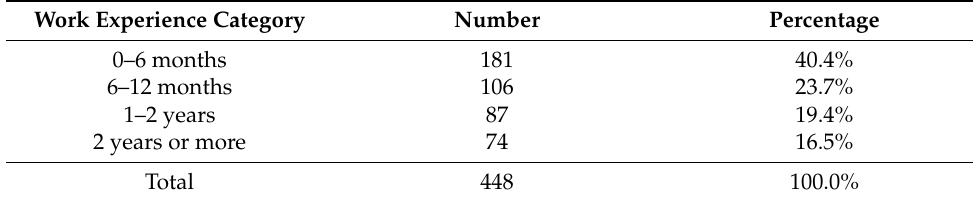
Table 2. Work experience distribution of